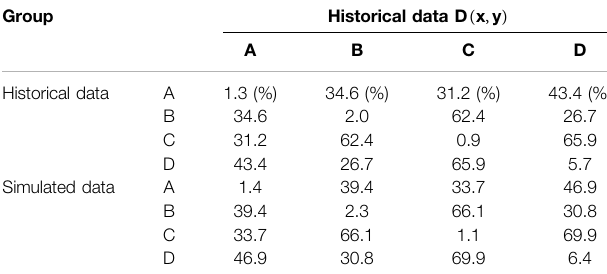
TABLE 2 | The similarity between simulated data and historical